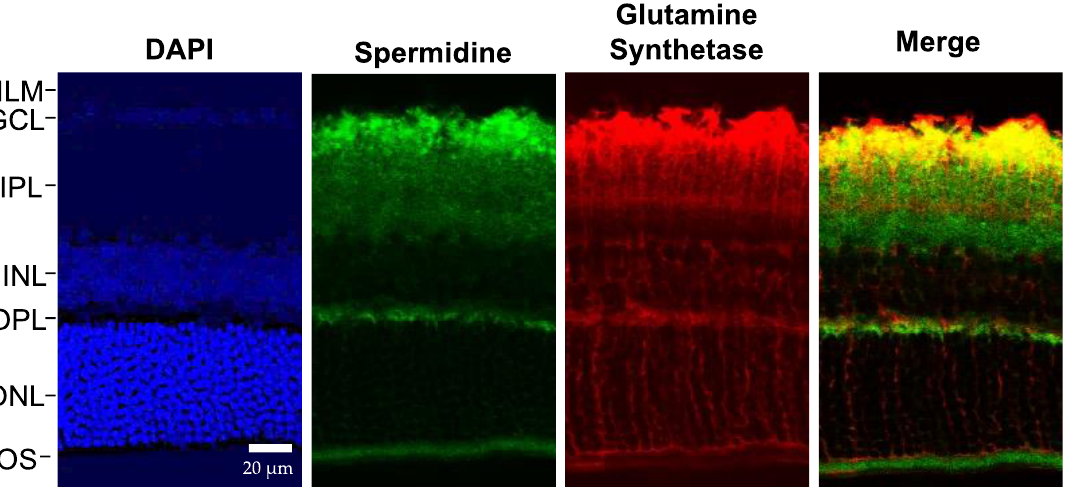
Figure 2. Spermidine (SPD) and Glutamine Synthetase (GS) immunolabeling in a 21-day-old (wean- ling: P21) rat retina. The retinal structure is represented by the schematic (left side) showing various types of retinal cells and the retinal layers. DAPI (blue) is a nuclear stain. SPD (green) is localized in Müller cell compartments and co-localized with the glial cell marker GS (red). Co-localized staining (merged, yellow). The strongest co-localization of SPD and GS was found in Müller cells (soma, endfeet, stalks, and distal processes) and in the area of contact of Müller cells with synapses of photoreceptors and their inner segments. Insert shows strong SPD labeling within the soma of Müller cells and their processes. (ILM-inner limiting membrane where endfeet of Müller cells make a border between the retina and vitreal humor; GCL-ganglion cell layer; IPL-inner plexiform layer, the synapses of neurons; INL-inner nuclear layer, the bodies of bipolar, horizontal cells and Müller cells; OPL-outer plexiform layer, the synapses of photoreceptors; ONL-outer nuclear layer, the cell bodies of photoreceptors; OS-outer segments-the photosensitive segments of photoreceptors).